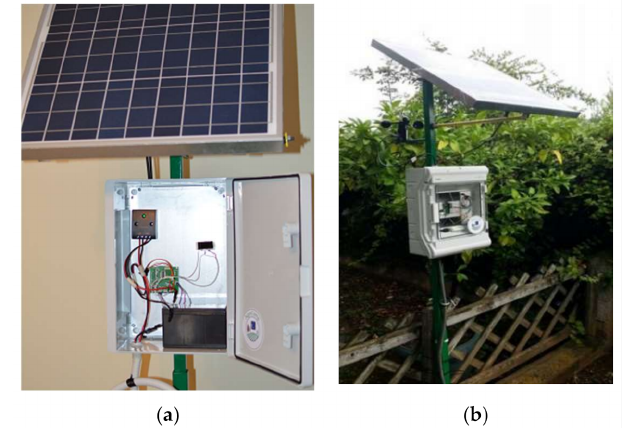
Figure 3. AgroComp Units: ( a ) Testbed Unit, ( b ) Production Unit.